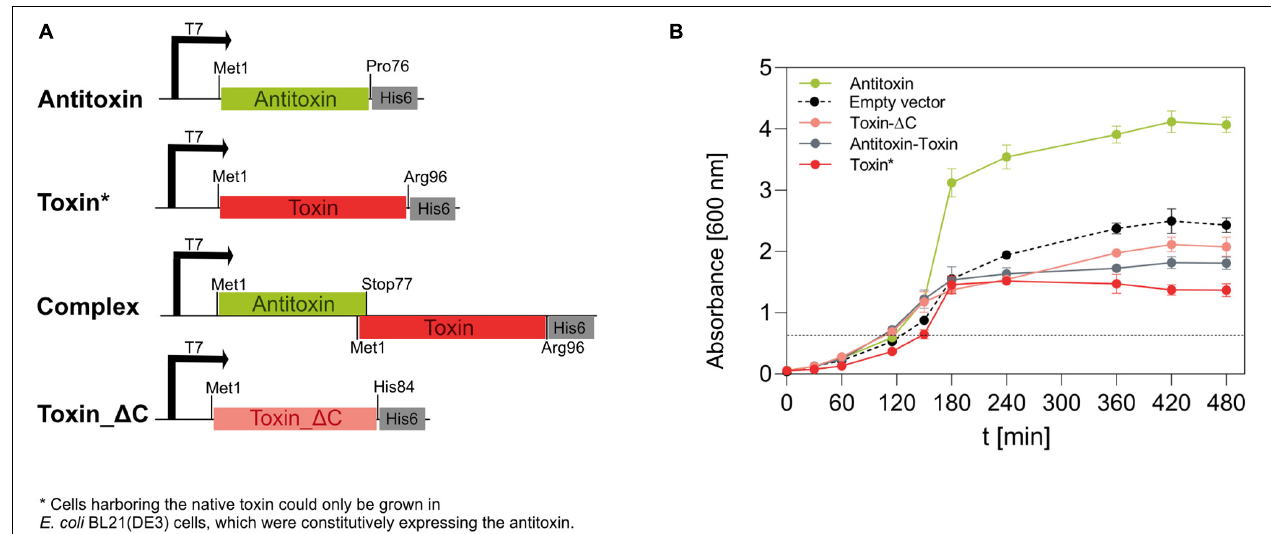
FIGURE 3 | Expression of the 1065 (toxin) and 1067 (antitoxin) genes in E. coli BL21(DE3) cells. (A) We constructed four pET28b(+)-based vectors that, under the IPTG-inducible T7 promoter, directed the expression of the native antitoxin, the native toxin, the native TA pair (complex) or the C-terminally truncated toxin in E. coli BL21(DE3) cells. All genes were inserted in frame with the 3’ His-tag coding sequence. (B) The growth of E. coli BL21(DE3) cells at 37 ◦ C and shaken at 200 rpm was monitored for 480 min by measuring the optical density at 600 nm. The expression of genes under the T7 promoter was induced by 1 mM IPTG when OD 600 reached about 0.6 (dotted line). Cells containing the pET28_toxin plasmid were co-transformed with the pSB1C3_antitoxin plasmid, allowing constitutive expression of the antitoxin under a strong promoter and a strong ribosome binding site. Cells transformed with the empty pET28b(+) vector were used as controls. Although no gene was under the regulation of the T7 promoter, IPTG was also added at the indicated time point.